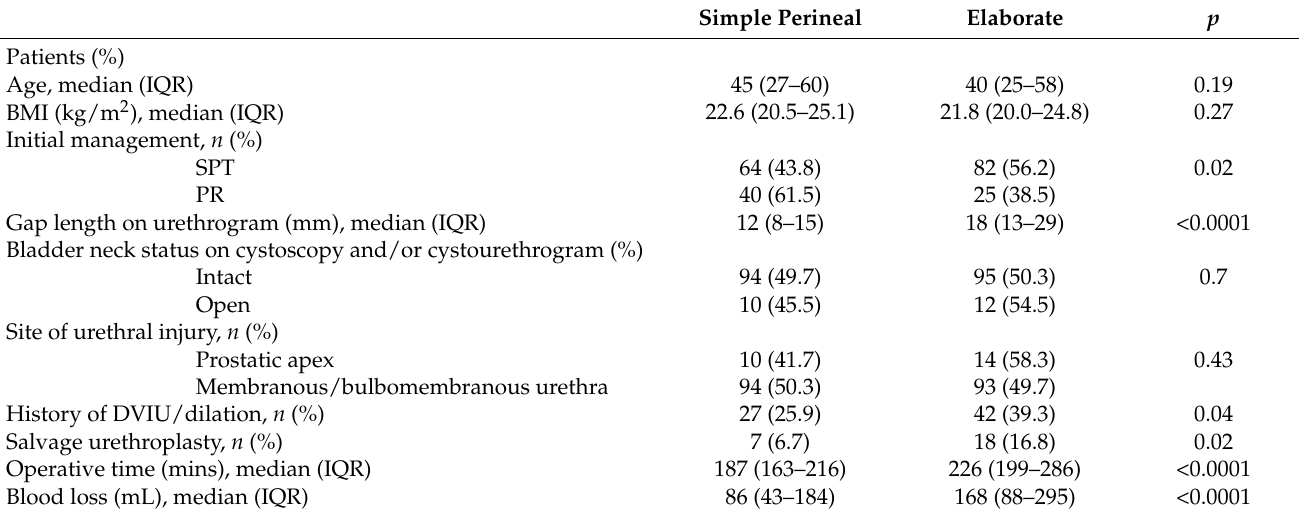
Table 2. The association of delayed anastomotic urethroplasty (DAU) type with clinical parameters.